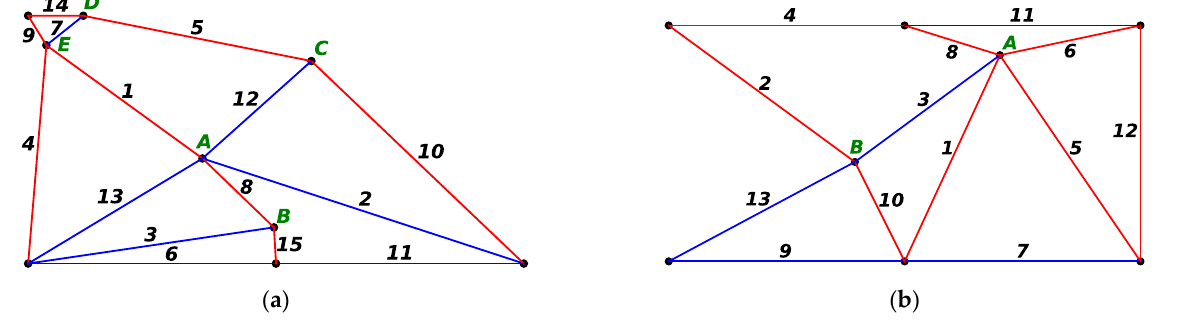
displayed in Figure 11 and Table 8.